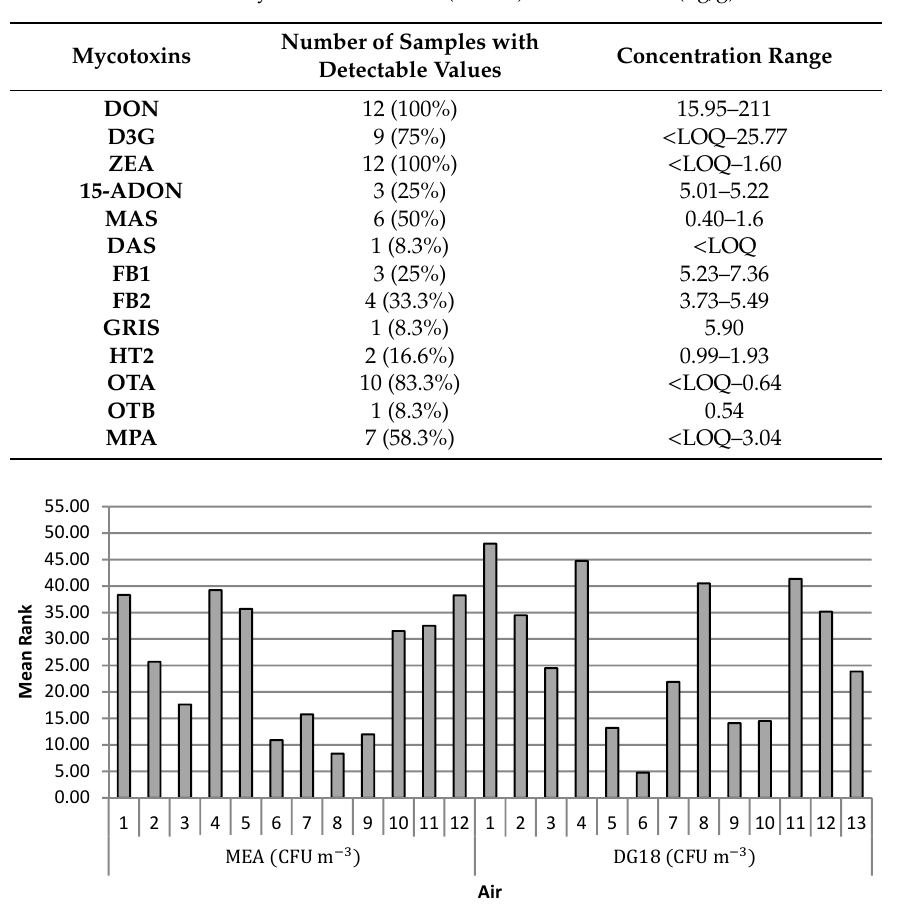
Figure 2. Mean ranks of fungal load (CFU m − 3 ) on MEA and DG18 on the air in each bakery.